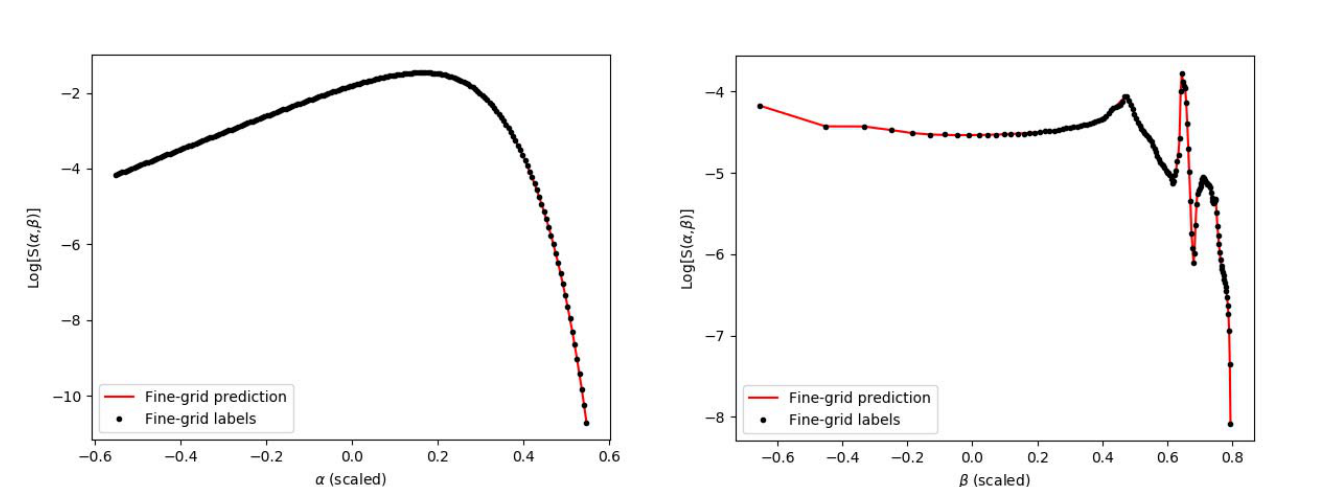
Figure 4. Representative 1-D (left, TSL v. (cid:10) for arbitrary (cid:11)/(cid:12) , and right, TSL v. (cid:11) for arbitrary (cid:10)/(cid:12) ) model predictions (red line) for Be in BeO against a test evaluation grid (black dots).